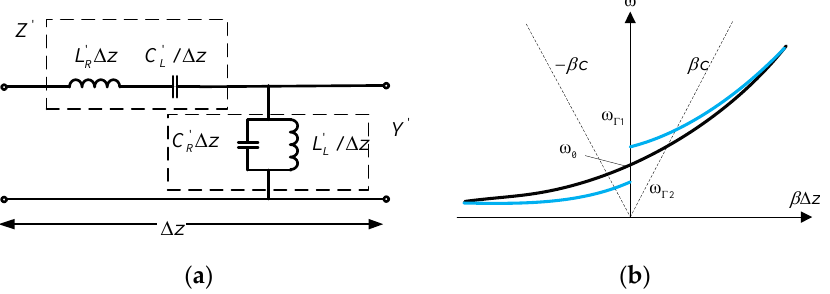
Figure 2. ( a ) The circuit model of a unit cell of with composite right/left-handed transmission lines (CRLH TLs) consists of two structures: A parallel resonant topology and a series resonant topology, and ( b ) the dispersion curve is obtained when the electromagnetic wave through the circuit of the unit cell with a length of Δ z , where the ω Γ 1 and ω Γ 2 are the two frequencies of zero-order resonance.